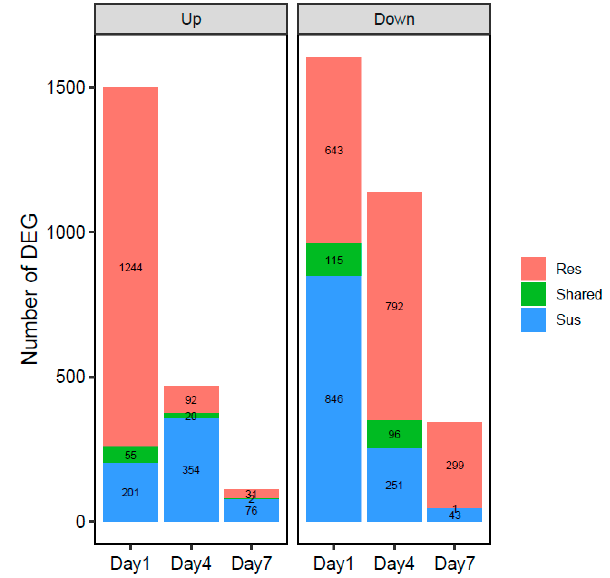
Figure 4. Comparison of DEG between resistant (Res) and susceptible (Sus) cultivars at 1, 4, and 7 days post-inoculation. The number in the bar graph indicated the number of DEG in each cultivar or shared (green).